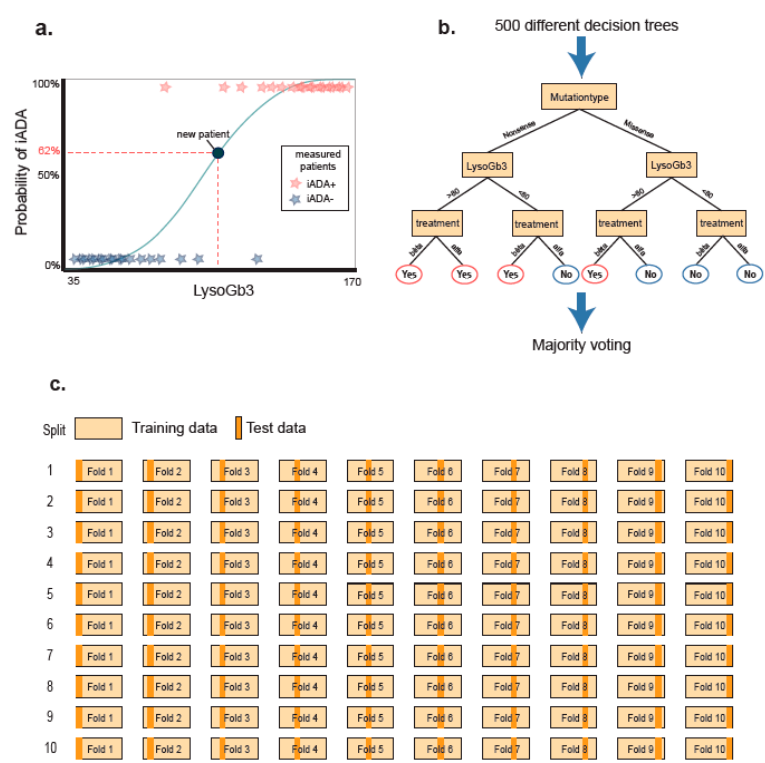
Figure 3. Visualization of used methods. ( a ) Logistic regression uses a combination of independent variables to draw a sigmoid curve that fits best with the training data. New subjects are plotted on the curve to calculate the risk of iADA development (in schematic presentation this is based on a single variable (lysoGb3), in reality all contributing variables weigh in in the predicted outcome). Blue stars resemble iADA negative subjects and the red stars represent iADA positive patients in the data set used to build the model. The blue dot represents a subject in the test set. ( b ) Random forest is a classification algorithm. It randomly creates multiple decision trees (default is 500). Each tree results in a conclusion (e.g., iADA yes or no), majority voting of all trees is used to determine risk of iADA development; ( c ) Cross-validation is a resampling procedure used to evaluate predictive models with limited data. The goal is to optimize usage of data and minimize overestimation of predictive accuracy. The data was randomly split in 10 subsets. For each iteration 9 sets are used to build the model and one to test the model, until every subject has been in both groups. This procedure is repeated 10 times, until 100 models are built. Outcome of each individual patient were averaged and used to build the final